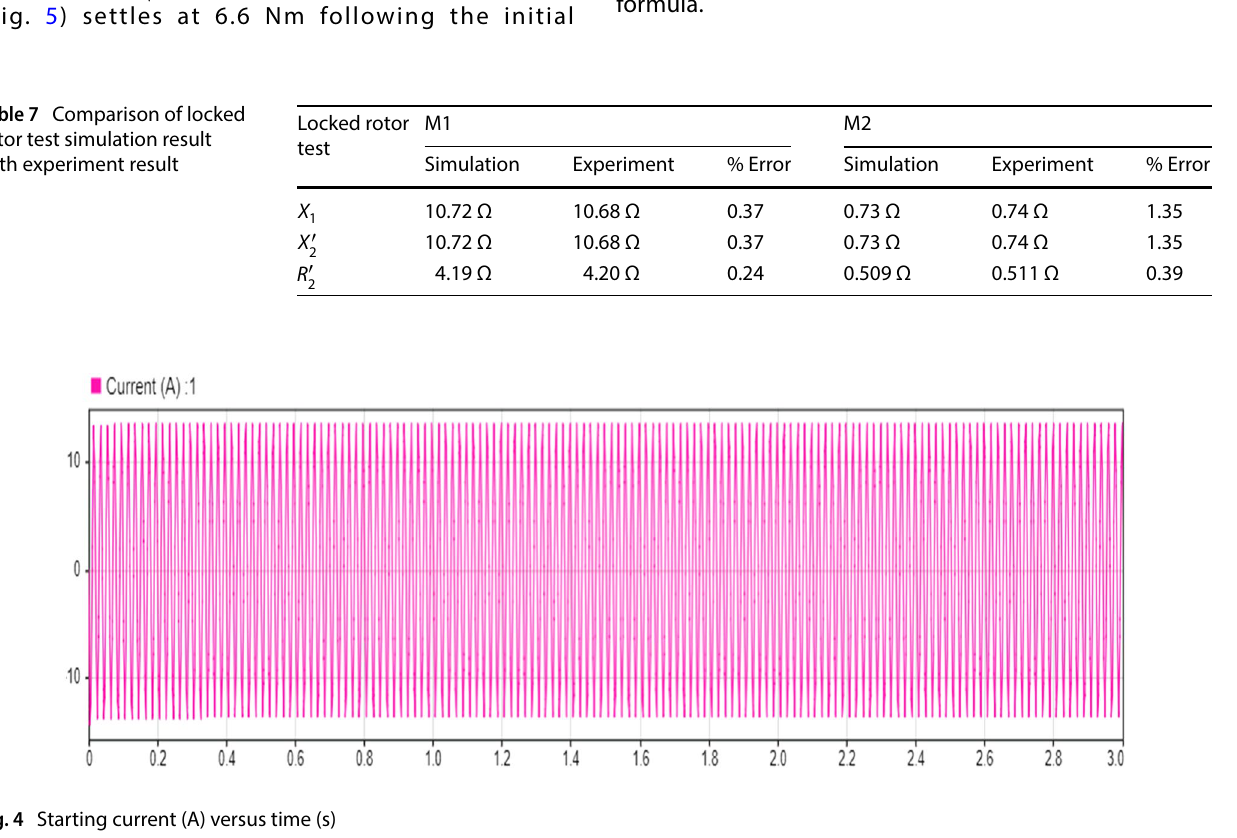
Fig. 4 Starting current (A) versus time (s)